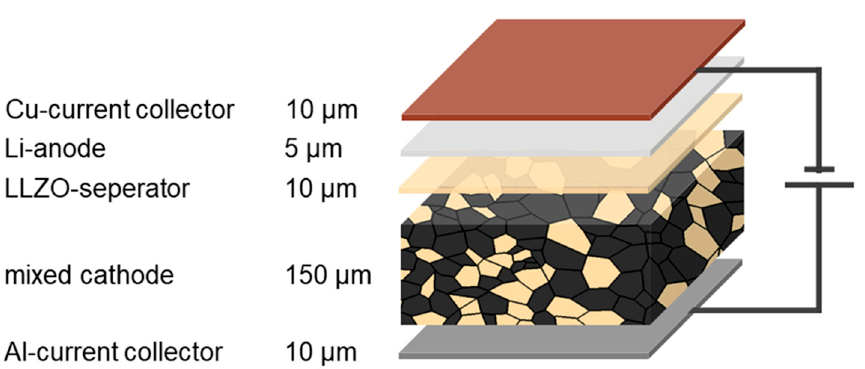
Figure 1. Pouch cell design of a ceramic ASB: A thick mixed cathode is separated by a thin LLZ-layer from the Li-metal anode. The currents are collected by a thin Cu or Al